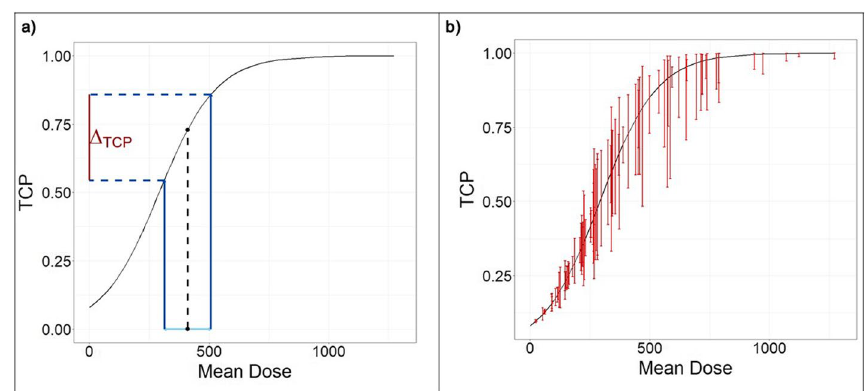
Fig. 5 Volume uncertainty propagated into tumor control probability (TCP), applied on the data and TCP curve fitted in the study by Dewaraja et al. [7]. a Procedure for computing Δ TCP for an example patient. b Original TCP curve (black line) overlaid by Δ TCP for 89 liver